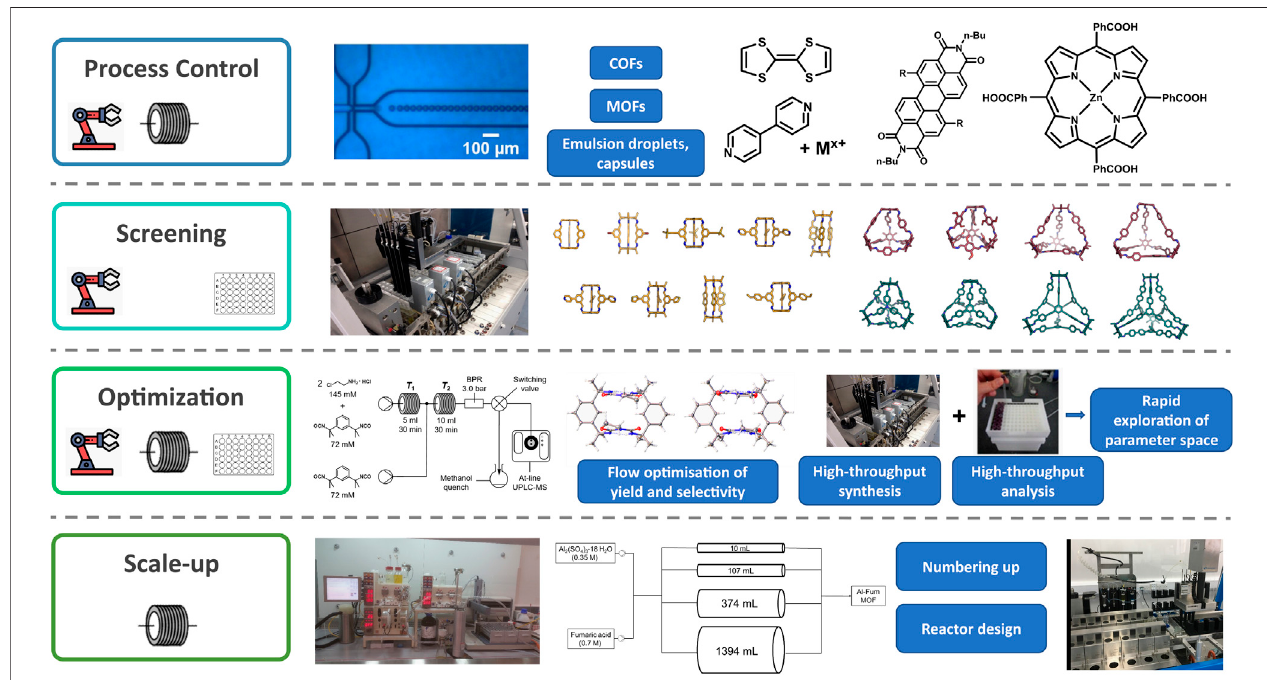
FIGURE 2 | Examples of supramolecular species and precursors and self-assembly processes that have been examined or enhanced using enabling technology for process control (Puigmartí-Luis et al., 2010; Numata et al., 2015a; Rubio-Martinez et al., 2016b; Gong et al., 2016; Thorne et al., 2019; Puigmarti-Luis et al., 2021, This fi gure contains an image of Figure 2a from Thorne et al. that has been used to make this composite fi gure under the terms of a Creative Commons Attribution 4.0 International License https://creativecommons.org/licenses/by/4.0/), screening (Greenaway et al., 2018), optimisation (Jones et al., 2021, The fl ow diagram and crystal structures in the optimization panel have been reused from Figure 2 and 11 from https://pubs.acs.org/doi/abs/10.1021/jacs.1c02891 respectively with permissionfrom the ACS.Further permission related tothe material excerpted shouldbe redirected totheACS), and scaleup (Briggs et al., 2015;Rubio-Martinez et al.,